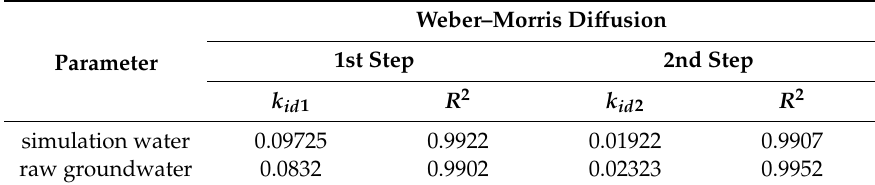
Table 8. Rate constants for the kinetic model of As(V) adsorption on NZVI / AC. Comparison of simulation water containing only As(V) vs. raw